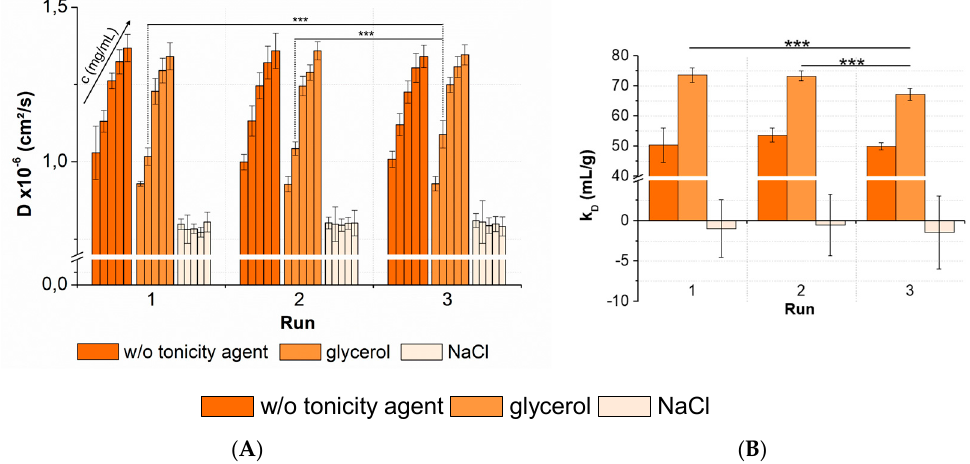
Figure 10. Statistical evaluation (inter-plate CV ) with regards to ( A ) diffusion coefficients collected for three peptide-12 formulations in acetate buffer, pH 4.5, in the absence or presence of tonicity agents (w/o tonicity agent: dark orange, glycerol: orange, NaCl: slight orange) concentrations (in ascending order: 2, 4, 6, 8, and 10-mg/mL peptide-12); 5 replicates; and 3 runs. Significant differences are indicated by asterisks: *** p < 0.001. The plate design is shown in Appendix A, Figure A2. ( B ) The k D obtained from the D of 5 concentrations (2, 4, 6, 8, and 10-mg/mL peptide-12) and 5 replicates at 3 plate positions collected in 3 separate runs (9 total k D of each formulation).